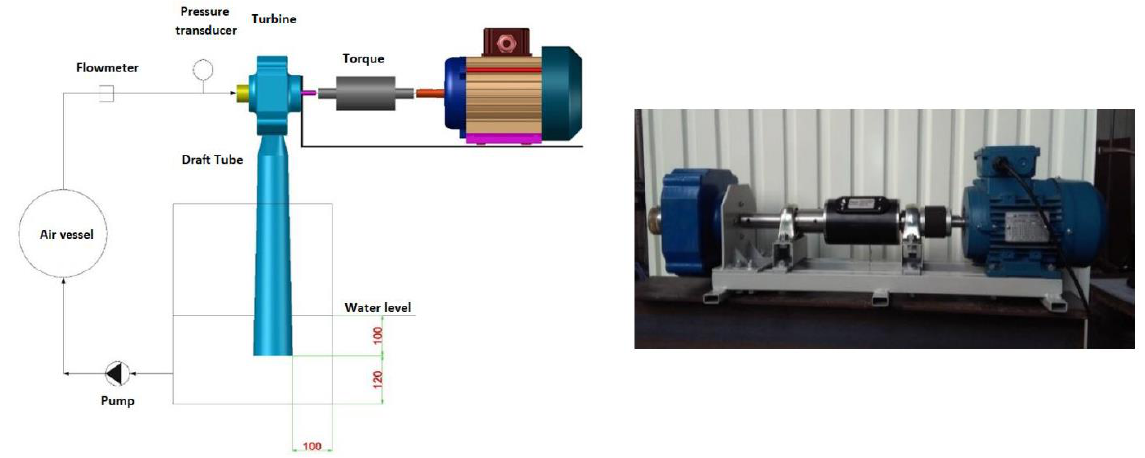
Figure 1. Experimental setup of the centrifugal turbine. Units: mm.